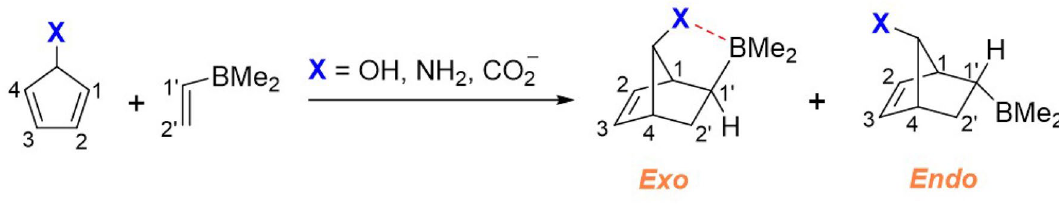
Figure 1. DA reaction of mono-substituted cyclopentadienes and dimethyl(vinyl)borane. The red dashed line represents the LAB